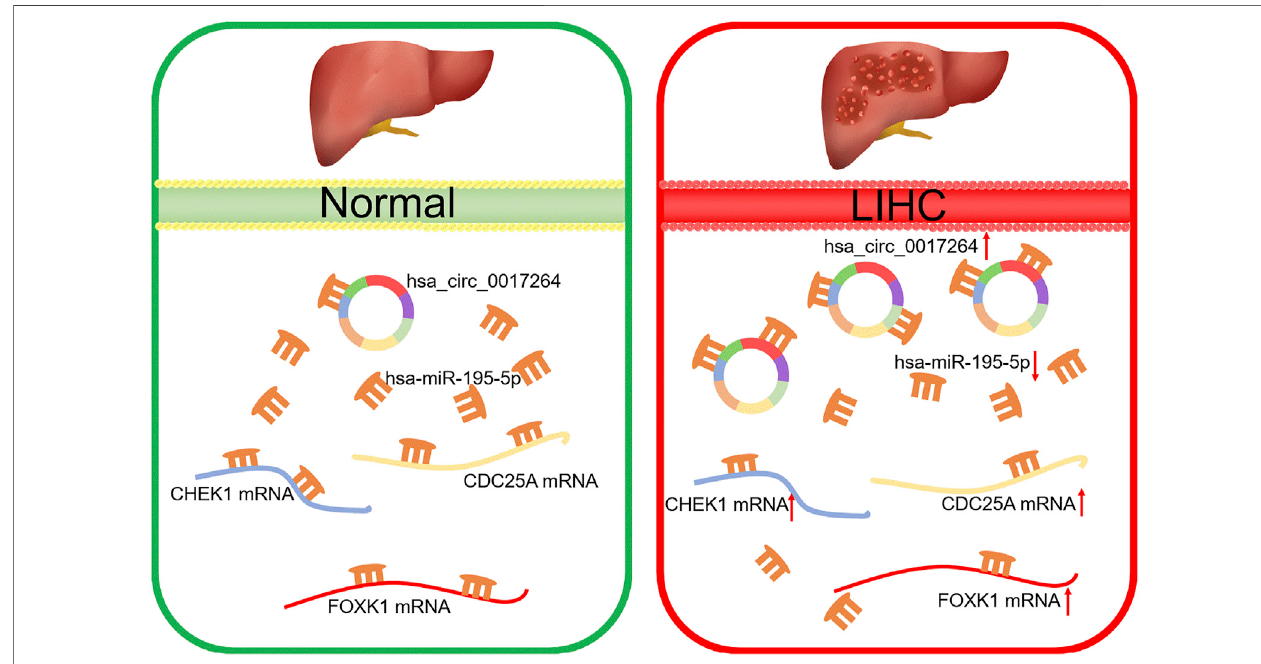
FIGURE 11 | Model of the hsa_circ_0017264-hsa-miR-195-5p-CHEK1/CDC25A/FOXK1 axis in LIHC.